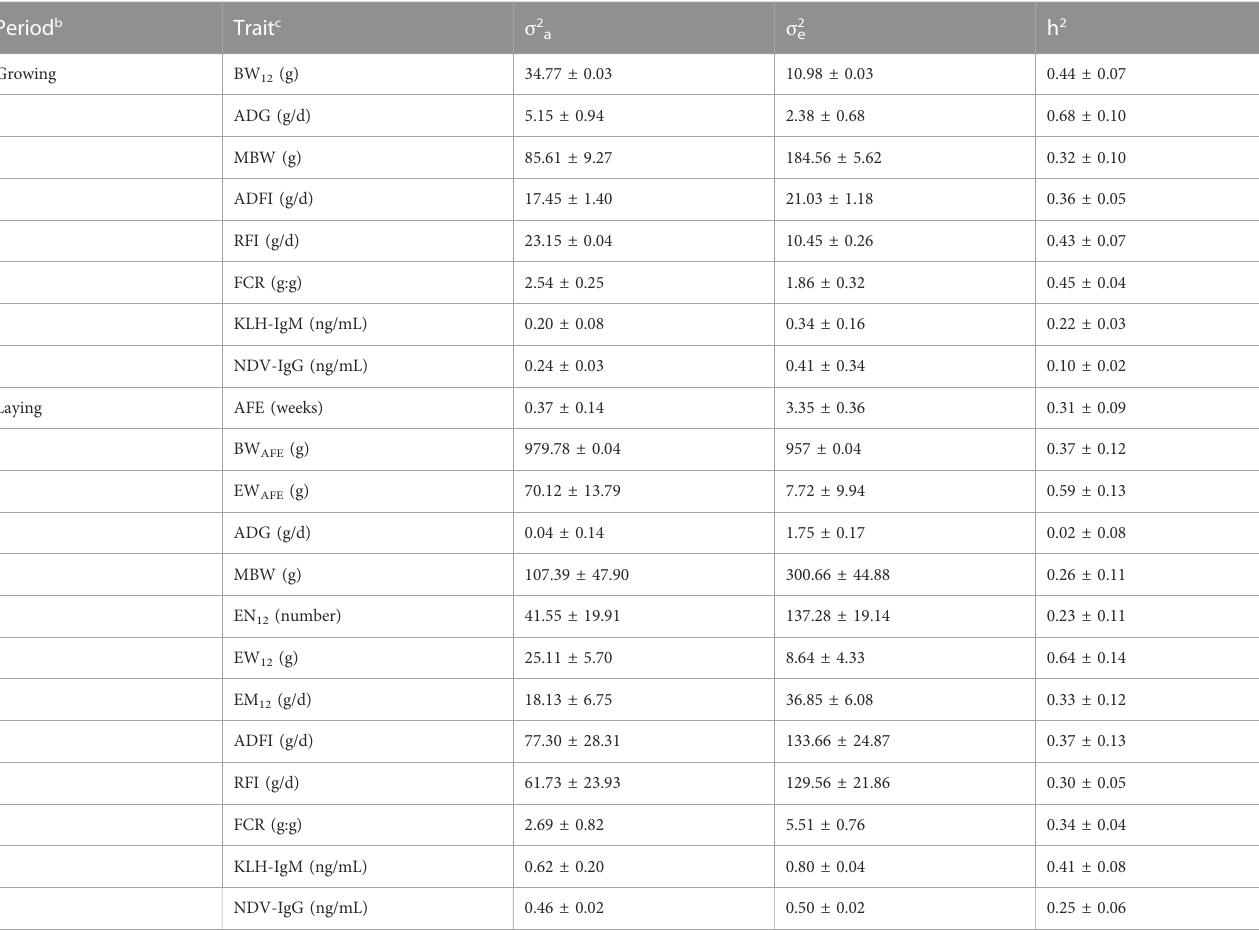
TABLE2Estimates ofadditive genetic variance ( σ a 2 ) 1 ,residual variance ( σ e 2 ) 1 andheritability (h 2 ) 1 ofproduction,feedef fi ciency andimmune traitsmeasured ingrowing and laying periods. Period b Growing